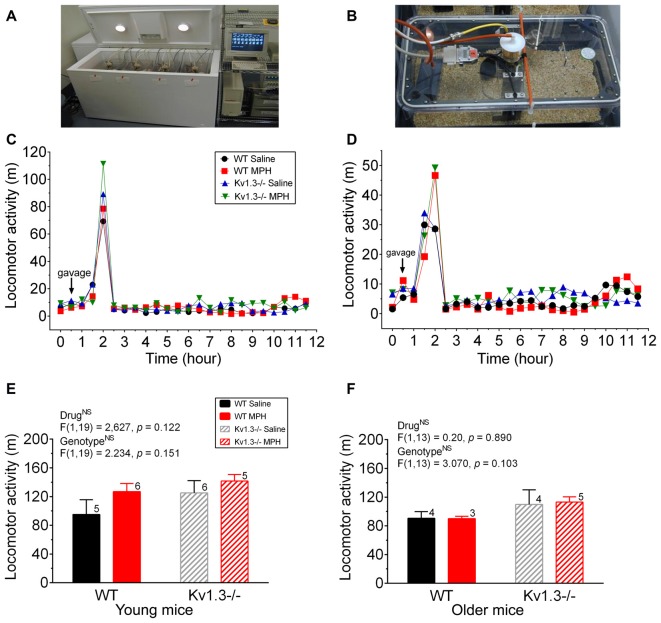
Locomotor activity is not significantly altered by MPH treatment. (A,B) Photograph of a custom-made metabolic chamber (A) and individual home cage that is sealed to perform indirect calorimetry as well as positioned on a platform to detect movement in a 50-mm unidirectional movement (B). (C,D) Line graph of the mean locomotor activity following an oral gavage of saline or MPH (arrow) initiated 2 h into the dark cycle for young (C) and older mice (D). (E,F) Bar graph of the mean locomotor activity for 10 h following oral gavage for young (E) and older mice (F). Same statistical analyses and notations as in Figure 1.